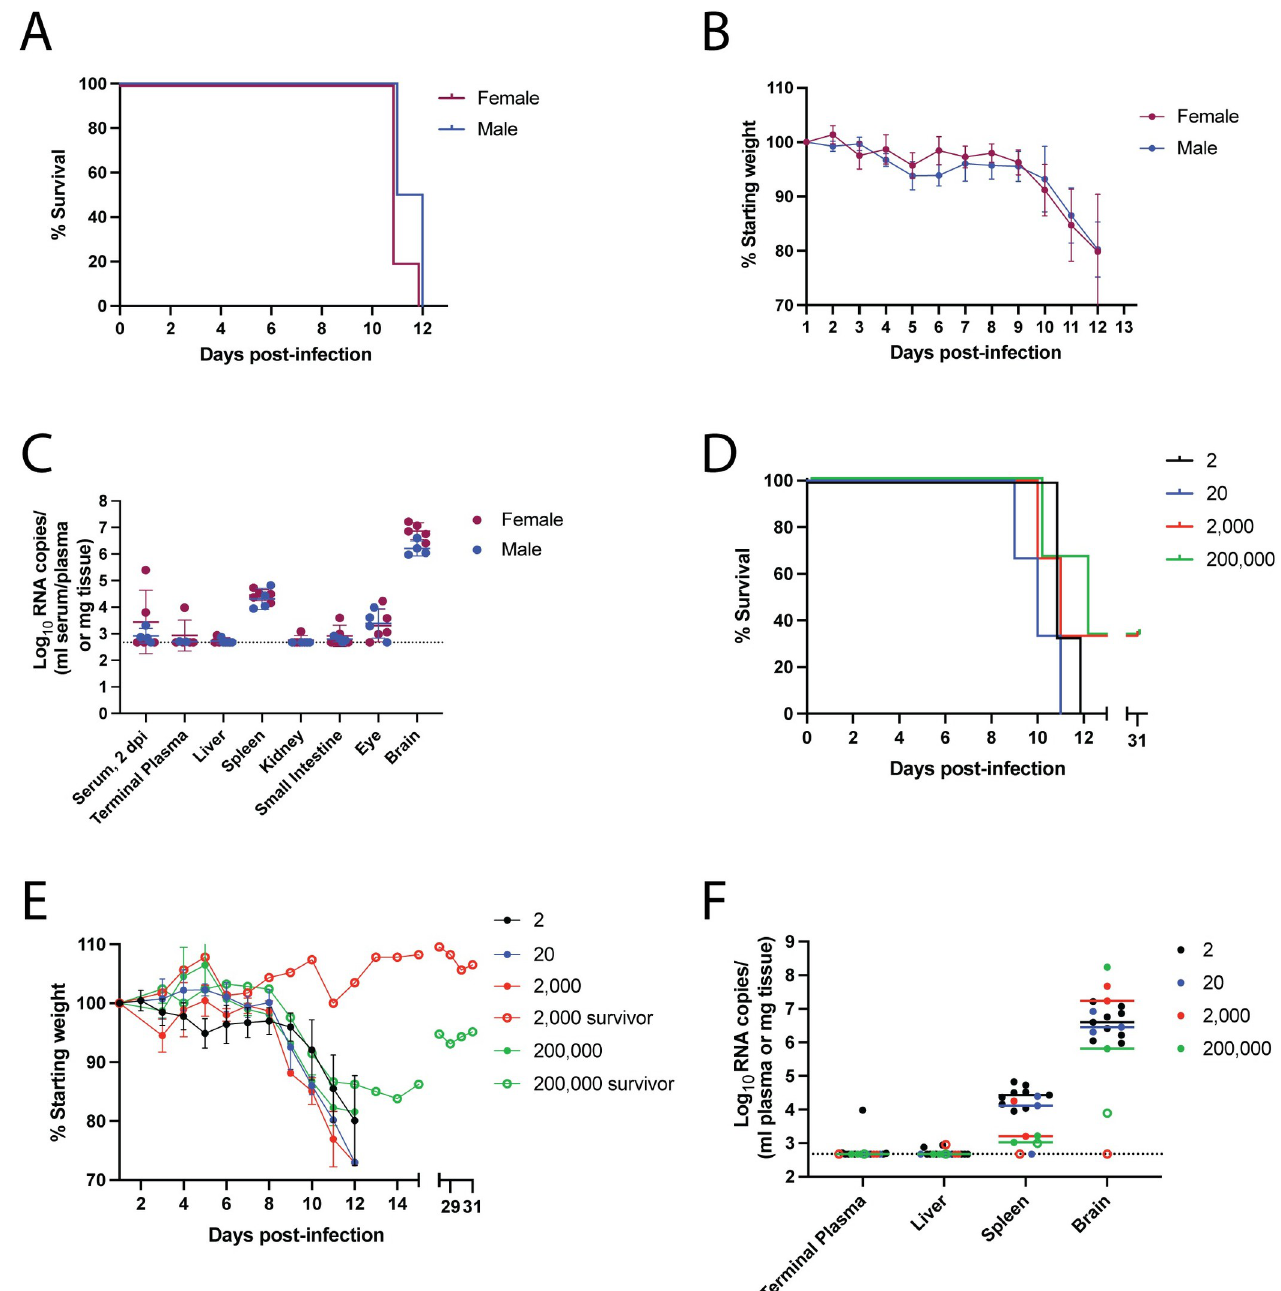
Fig 3. The RVF clinical phenotype in CC057 mice is not sex-dependent and was observed at increasing challenge doses. A) Survival curve of CC057 mice split by sex (female n = 5, male n = 4). B) Percent of starting body weight over the course of infection. Data presented as mean ± SD. C) qRT-PCR based assessment of viral RNA loads in CC057 serum at 2 dpi and tissues and plasma at time of euthanasia. Data previously presented in Figs 1 and S1, now split by sex. Data shown as geometric mean ± geometric SD. D) Survival curve of CC057 mice after challenge with different RVFV doses (2 TCID 50 n = 9; 20 TCID 50 n = 3; 2,000 TCID 50 n = 3; 200,000 TCID 50 n = 3). E) Percent of starting body weight over the course of infection after RVFV challenge at different doses. Survivor weights not plotted between 16 dpi and 27 dpi. Data presented as mean ± SD. F) qRT-PCR based assessment of viral RNA loads in CC057 tissues and plasma at time of euthanasia after RVFV challenge at different doses (2 TCID 50 n = 9; 20 TCID 50 n = 3; 2,000 TCID 50 n = 3; 200,000 TCID 50 n = 3). Data shown as geometric mean ± geometric SD. Survivor mice viral RNA titers are represented as open circles. 2 TCID 50 challenge dose data in panels D-F are the same 9 mice as presented before in panels A-C. LOD for tissue samples noted by dotted line at 473 RNA copies. LOD for serum, 2dpi samples = 18,960 RNA copies. LOD for terminal plasma samples = 9,480 RNA copies.